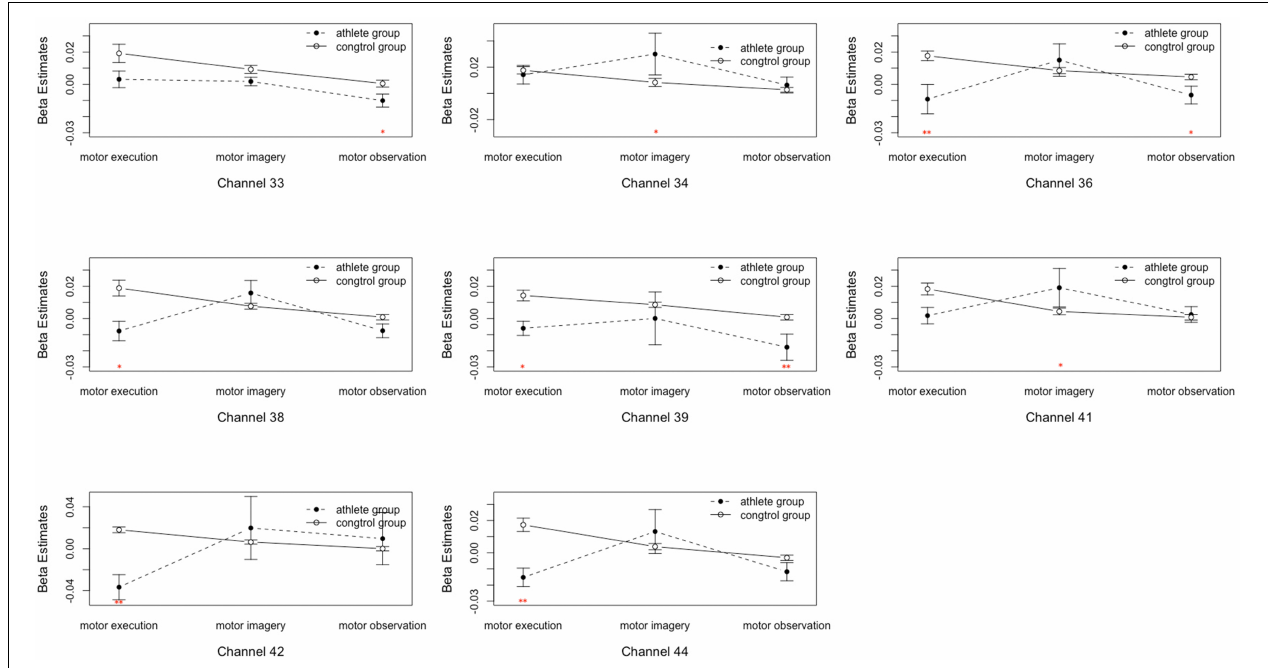
FIGURE 5 | Analysis of the interactions between the motor tasks and subject groups. Error bars represent standard errors. ∗ P < 0.05, ∗∗ P <